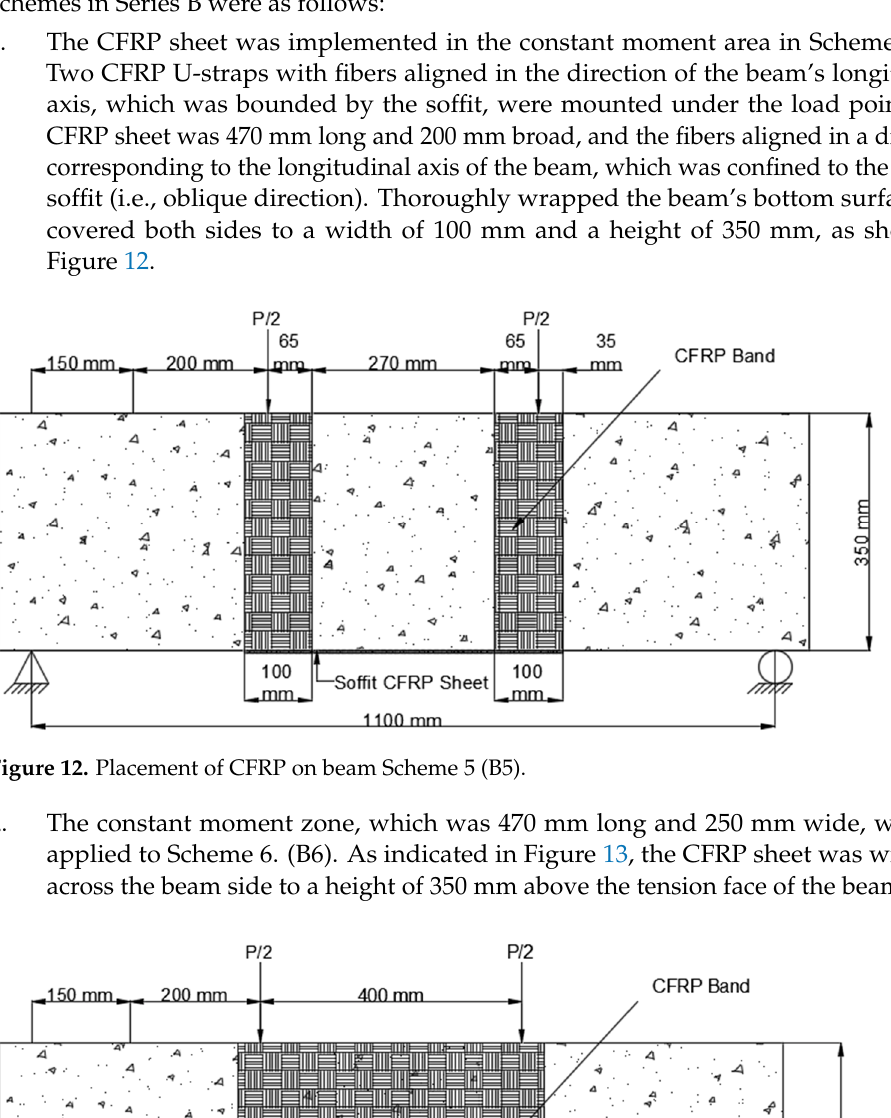
Figure 11. Placement of CFRP on beam Scheme 4 (B4).